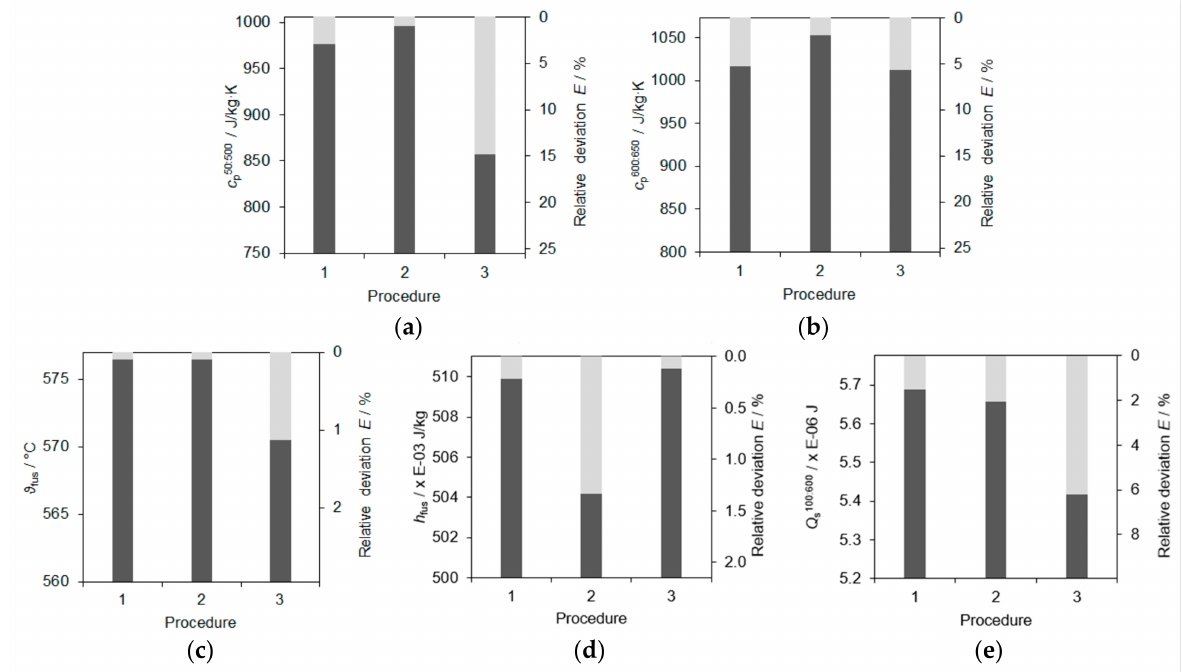
Figure 9. Absolute values of measuring procedures referring to simulation input values (maximum of primary ordinate) and relative deviation E (secondary ordinate). Procedure 1 = stepwise adiabatic procedure; 2 = isoperibolic procedure with loss correlation; 3 = isoperibolic procedure with cooling correlation. ( a ) Specific heat capacity between 50 ◦ C and 500 ◦ C; ( b ) specific heat capacity between 600 ◦ C and 650 ◦ C; ( c ) temperature of fusion; ( d ) specific heat of fusion; ( e ) heat stored in specimen between 100 ◦ C and 600 ◦